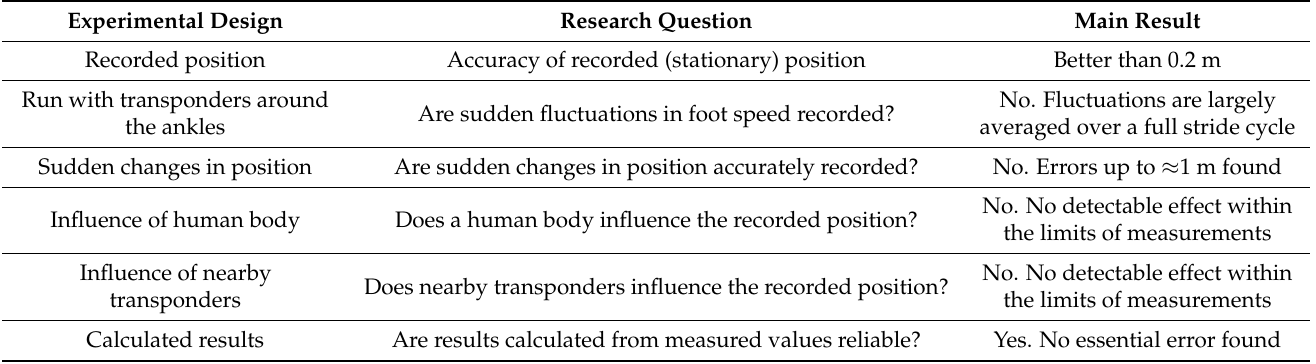
Table 2. Summary of the main experimental set-up, research questions, and the main